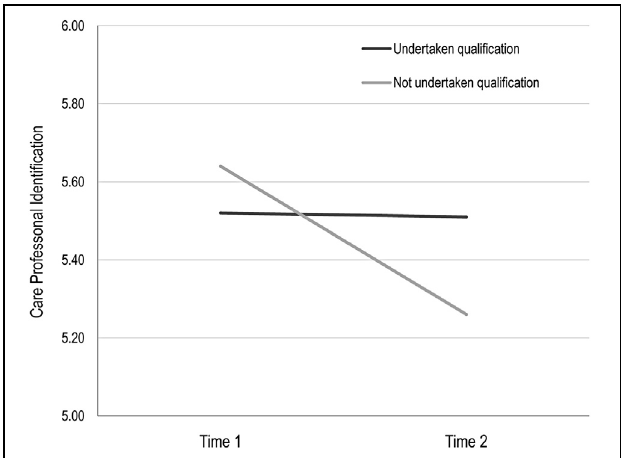
FIGURE 4 | The effects of undertaking a qualification on organizational identification, Longitudinal panel